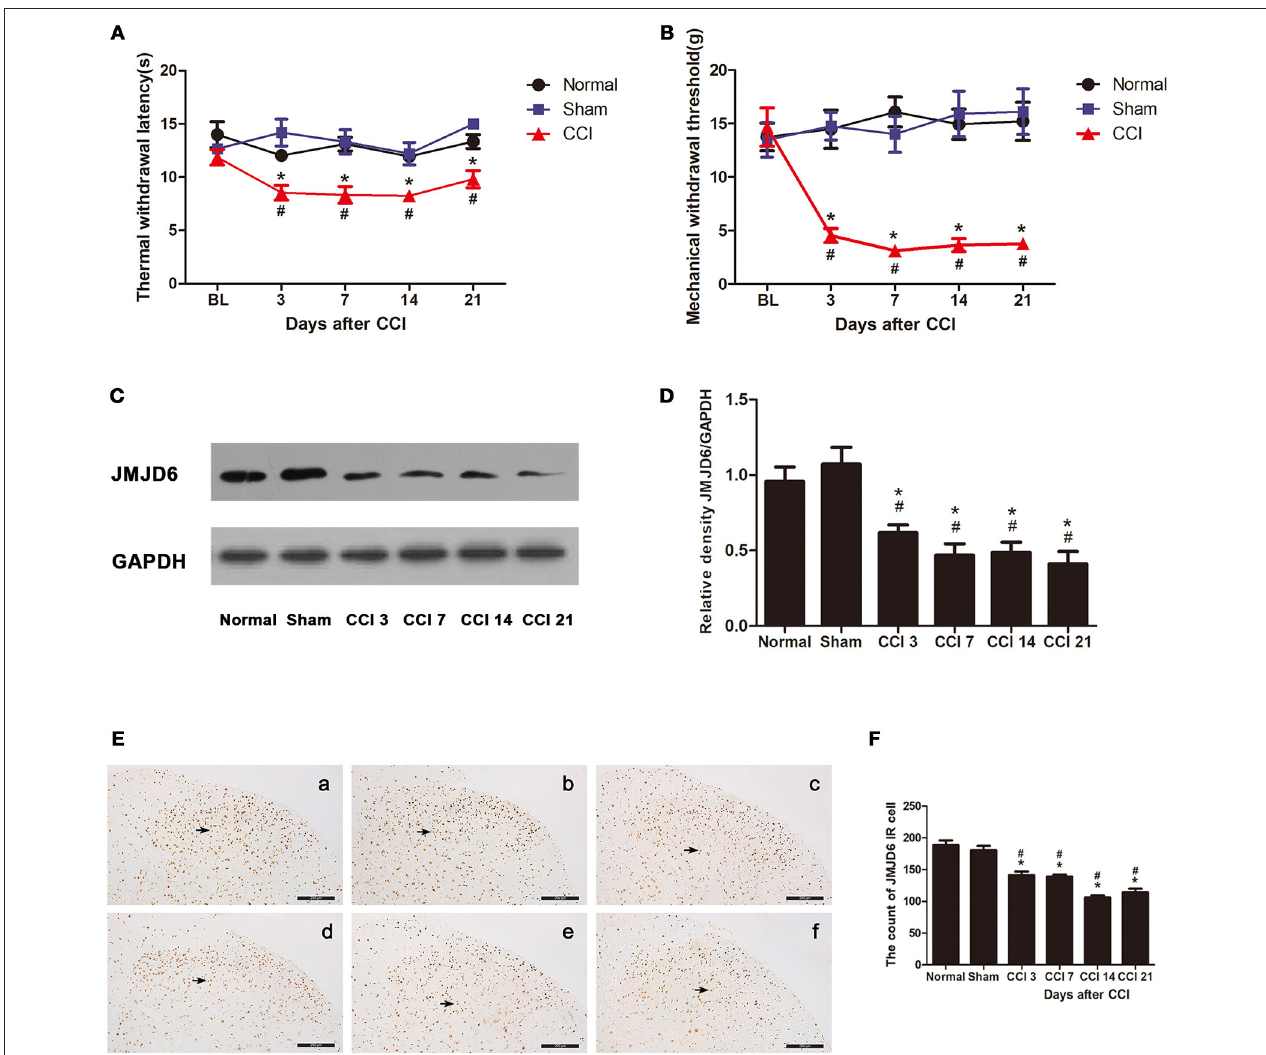
FIGURE 1 | Rats show decreased expression of JMJD6 in the spinal cord accompanied by hyperalgesia after CCI surgery. (A) Time course of thermal withdrawal latency (TWL) in rats (mean ± SEM, n = 5). (B) Time course of mechanical withdrawal threshold (MWT) in rats (mean ± SEM, n = 5). (C,D) JMJD6 protein expression was significantly decreased in the CCI group at 3, 7, 14, and 21 days post-CCI surgery ( n = 4). (E) The temporal distribution of JMJD6. Representative images of JMJD6 immunoreactivity are shown. (a) JMJD6 immunoreactivity in the normal group. (b) JMJD6 immunoreactivity in the sham-operated group. (c–f) JMJD6 immunoreactivity on days 3, 7, 14, and 21 post-CCI surgery. Arrows indicate representative JMJD6-positive cells. (F) Mean JMJD6 immunoreactivity at corresponding time points after CCI surgery, ( n = 4). # p < 0.05, CCI vs. normal group; * p < 0.05, CCI vs. sham